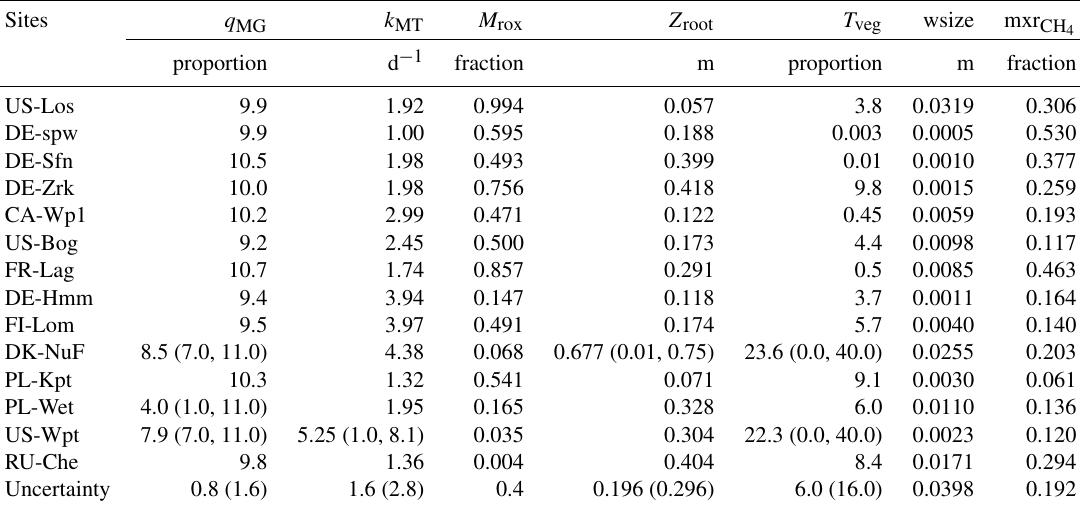
Table 4. Single site optimized values of methane scheme parameters for each peatland site. In parentheses are the prior parameter ranges which differ from the values in Table 3. Uncertainties for these ranges are specified in parentheses.